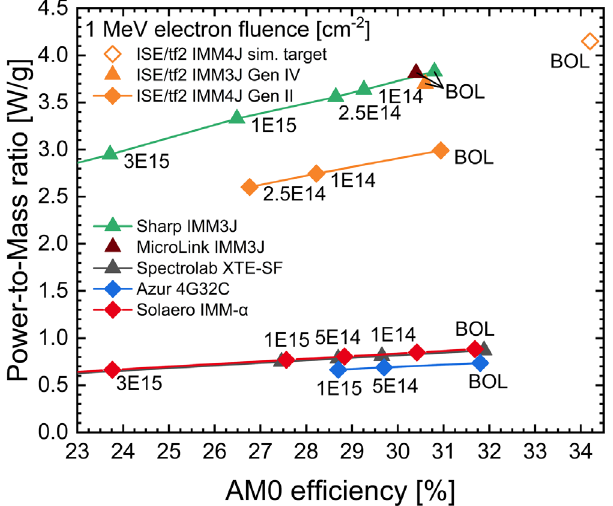
Fig. 7. AM0 power-to-mass ratios vs. ef fi ciencies plot of the IMM4J and IMM3J in comparison to commercial available solar cells. 1 MeV electron irradiation fl uences in e – /cm (cid:3) 2 are labelled on the symbols to show the degeneration of each cell. For the latest generation of IMM3J are unfortunately no irradiation results available yet. The 4G32C from Azur [5] and the XTE-SF from Spectrolab [6] are based on thinned Germanium substrates whereas the cells from Sharp [10] and MicroLink [22] are IMM3J based solar cells. The IMM based solar cells have a more than three times higher power-to-mass ratio in comparison to the thinned Germanium based devices. The IMM ‑ a from Solaero [7] is an IMM based solar cell but permanently bonded to a robust substrate and therefore not as lightweight as the other IMM based cells. The ISE/tf2 simulation target assumes an areal mass density of 11.27 mg/cm 2 (as for the Gen IV IMM3J) and the realistic ef fi ciency potential of 35.9% of the IMM4J design with a bandgap spread from 2.10 eV to 1.00eV.